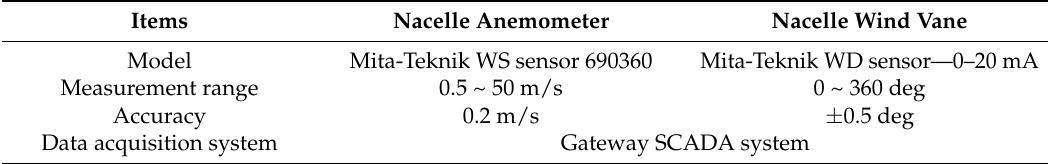
Table 2. Specifications of nacelle wind sensors and the SCADA system.